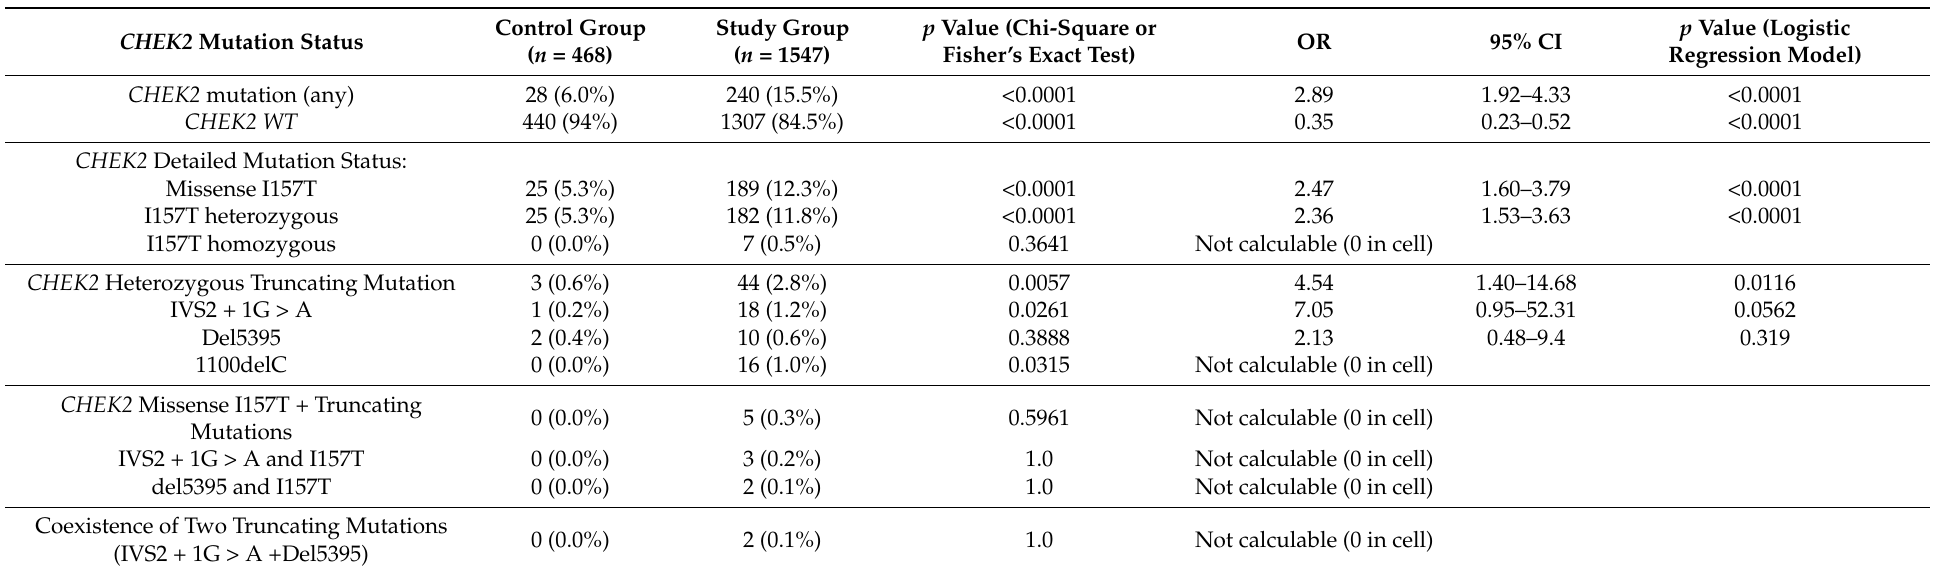
Table 2. Relationship between CHEK2 mutation genotype and PTC